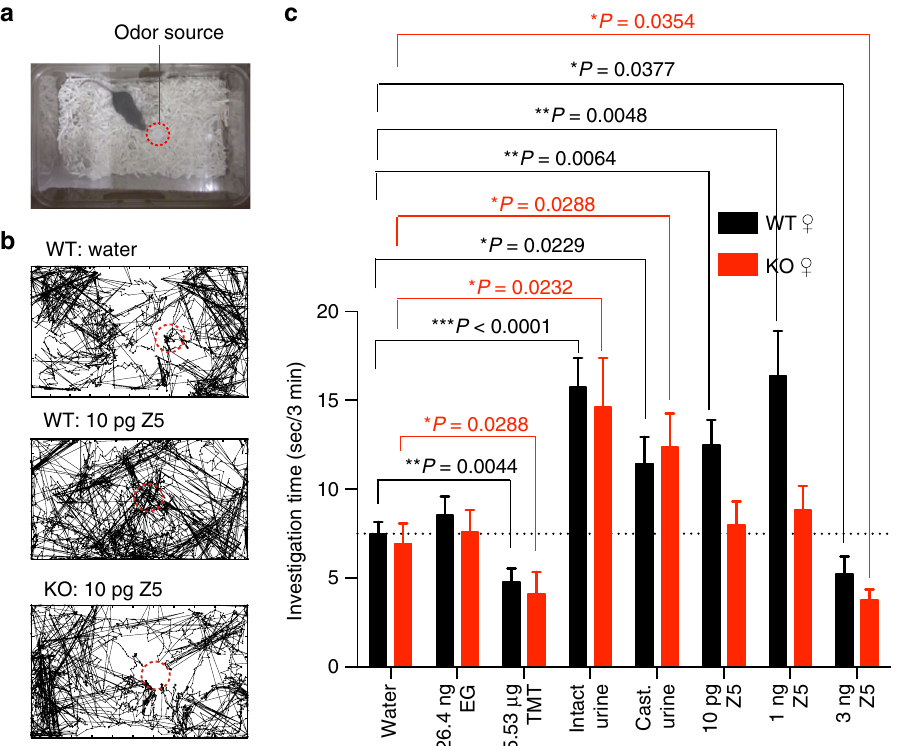
Fig. 4 Aversion to high amounts of Z5 – 14:OH in both wild type and Olfr288 knockout mice. a Setup of the odor investigation assay. A mouse was exposed for 3 min to a fi lter paper bearing odorant placed in the middle of cage. The time the mouse spent investigating the odor source was measured. b Representative traces of wild type (WT) and Olfr288 knockout (KO) mice investigating 10 pg Z5 – 14:OH. c Odor investigation assay for various amounts of Z5 – 14:OH, intact or castrated urine, eugenol, or TMT, in adult female C57BL/6 mice (black bars) ( N = 15) and adult female Olfr288-KO mice (red bars) ( N = 10). Eugenol was diluted in mineral oil. TMT was diluted in PG. Z5: Z5 – 14:OH; oil: mineral oil; EG, eugenol; PG, propylene glycol. Data are means ±